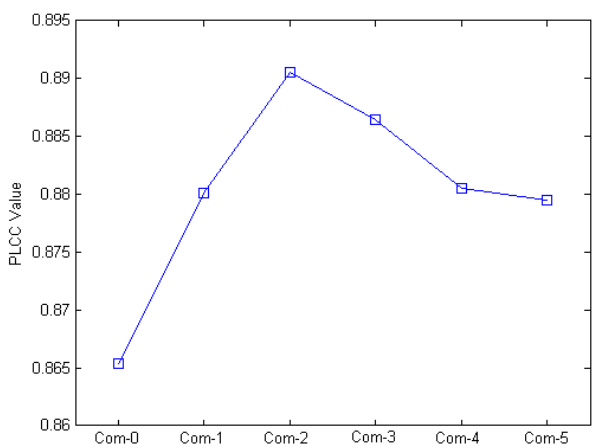
Figure 10. The curve of PLCC values for different combinations of HOG features.